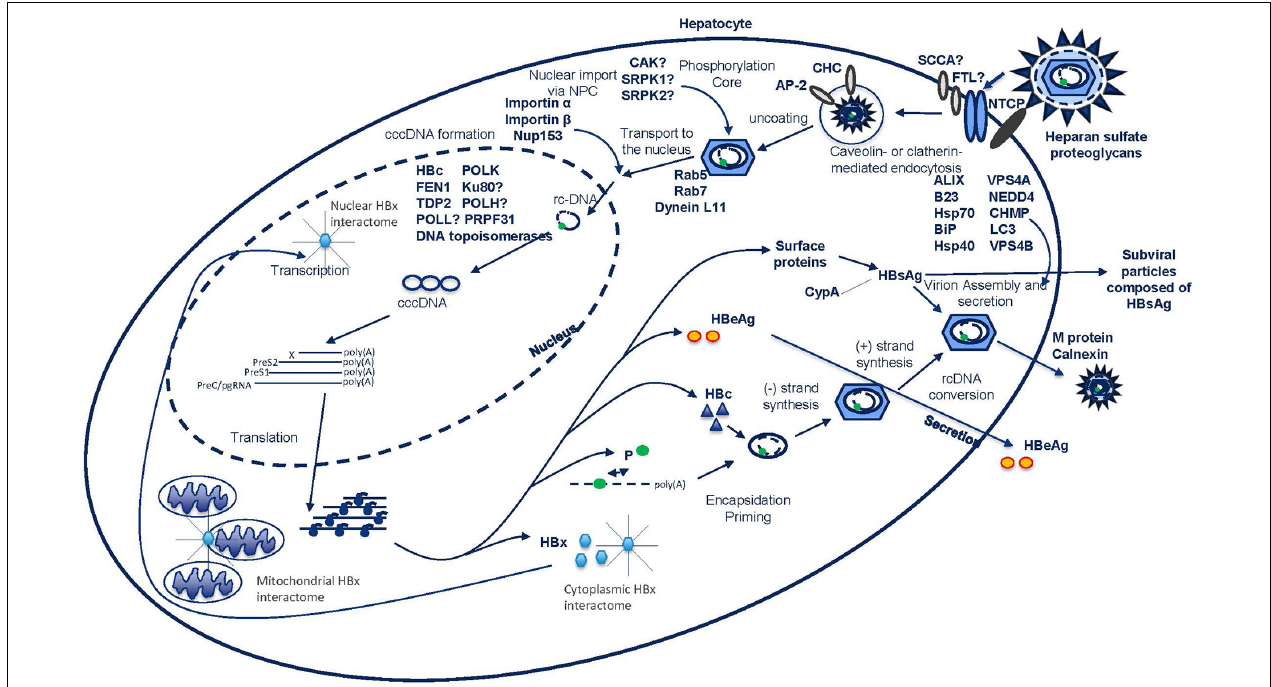
FIGURE 1 | HBV life cycle from viral entry to